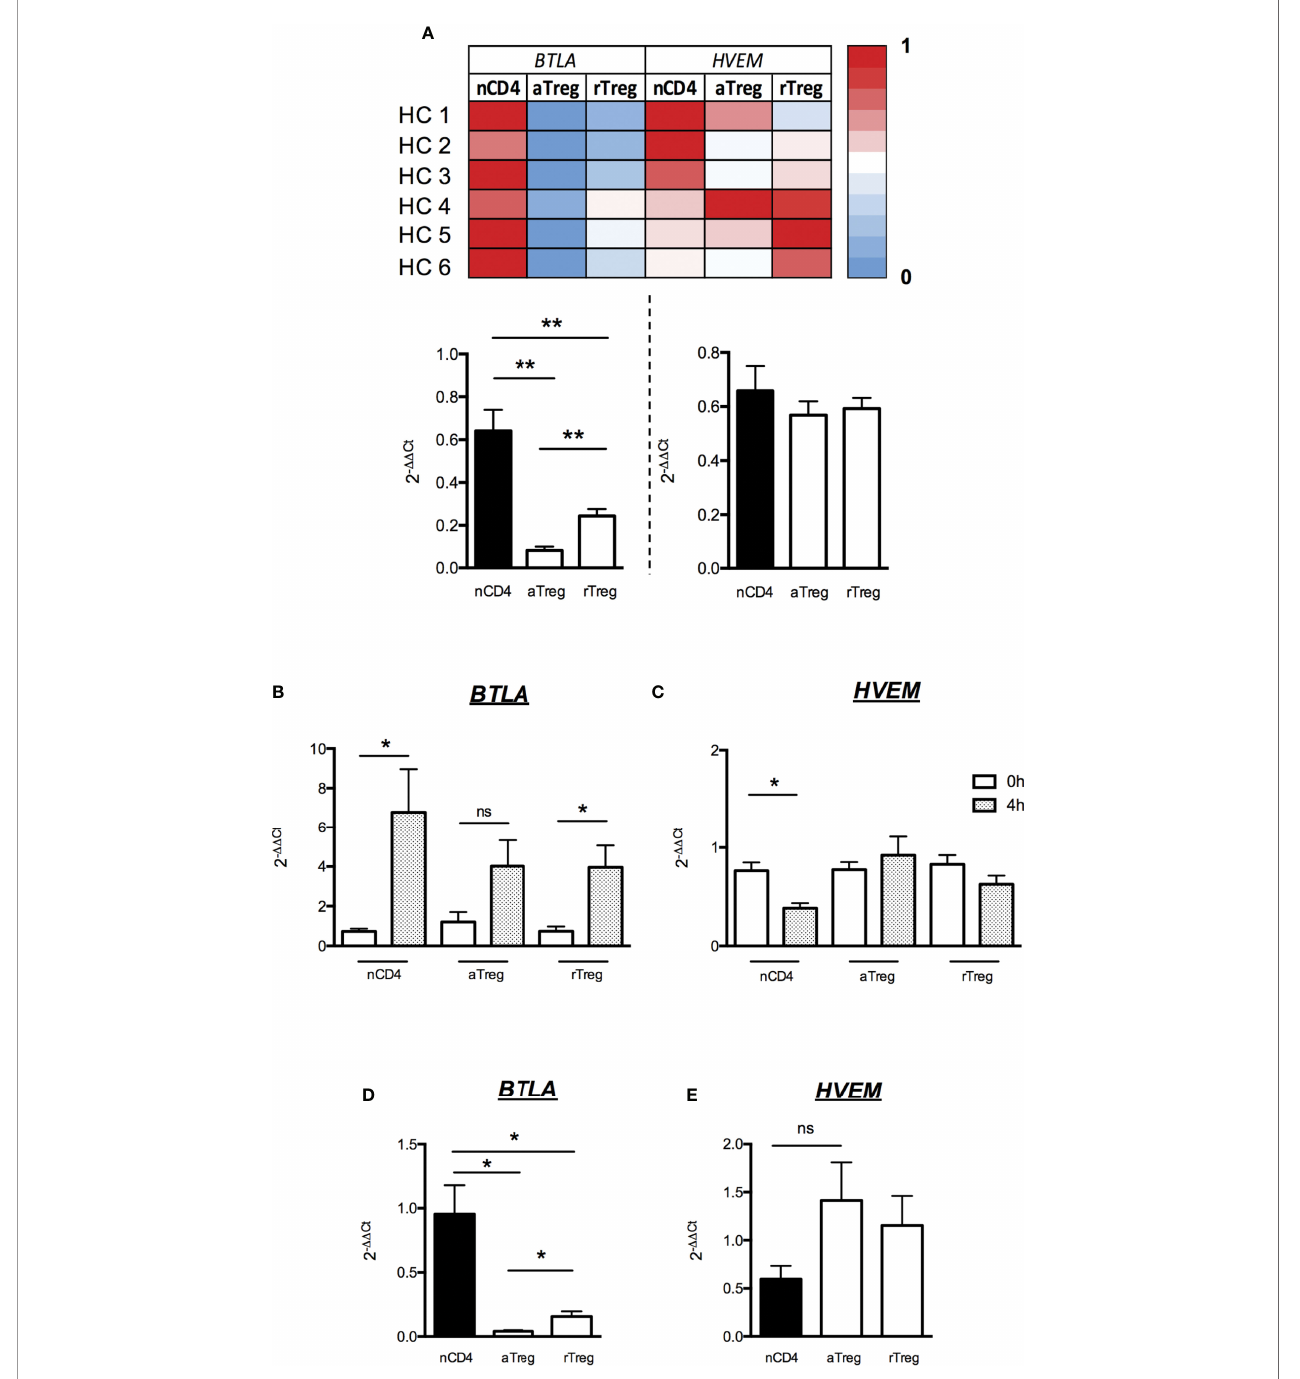
FIGURE 4 | Low BTLA mRNA expression and maintained HVEM mRNA expression by Tregs after activation. (A) Levels of BTLA and HVEM transcripts were assessed by RT-qPCR on FACS-sorted naive CD4 + T cells (nCD4), aTregs and rTregs. Heatmap shows qPCR values of BTLA and HVEM transcripts normalized to GAPDH and ACTB. Results show average qPCR values from 6 HC and are expressed as fold change (2 - DD Ct ) compared to nCD4 + T cells. (B, C) BTLA and HVEM mRNA expression by naive CD4 + T cells, aTregs and rTregs from HC (n=4) following activation. Cells were stimulated with anti-CD3 (5µg/ml) and anti-CD28 (5µg/ml) Abs for 4 hours and harvested for analysis of BTLA and HVEM mRNA expression by RT-qPCR. Results show average qPCR values at t=4h and are expressed as fold change (2 - DD Ct ) compared to qPCR values at t=0. (D, E) Comparison of BTLA (D) and HVEM (E) mRNA expression between nCD4 + T cells, aTregs and rTregs from HCs (n=4) after 4 hours of stimulation (as described above). Results show fold changes (2 - DD Ct ) of qPCR values compared to nCD4 + T cells (n=4). Results are expressed as mean ± SEM. *p < 0.05; **p < 0.01, Mann-Whitney. ns, non signi fi